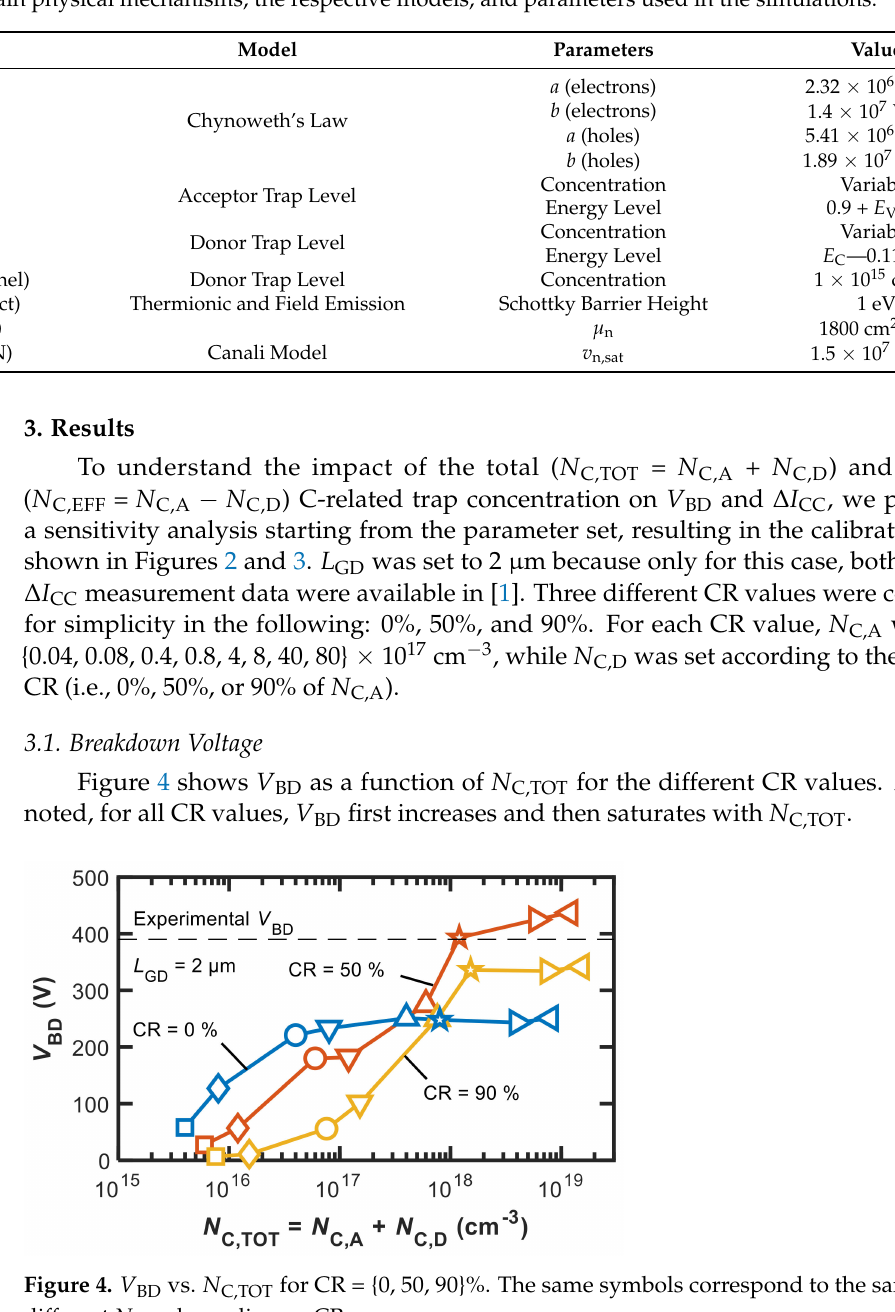
Table 1. List of main physical mechanisms, the respective models, and parameters used in the simulations.